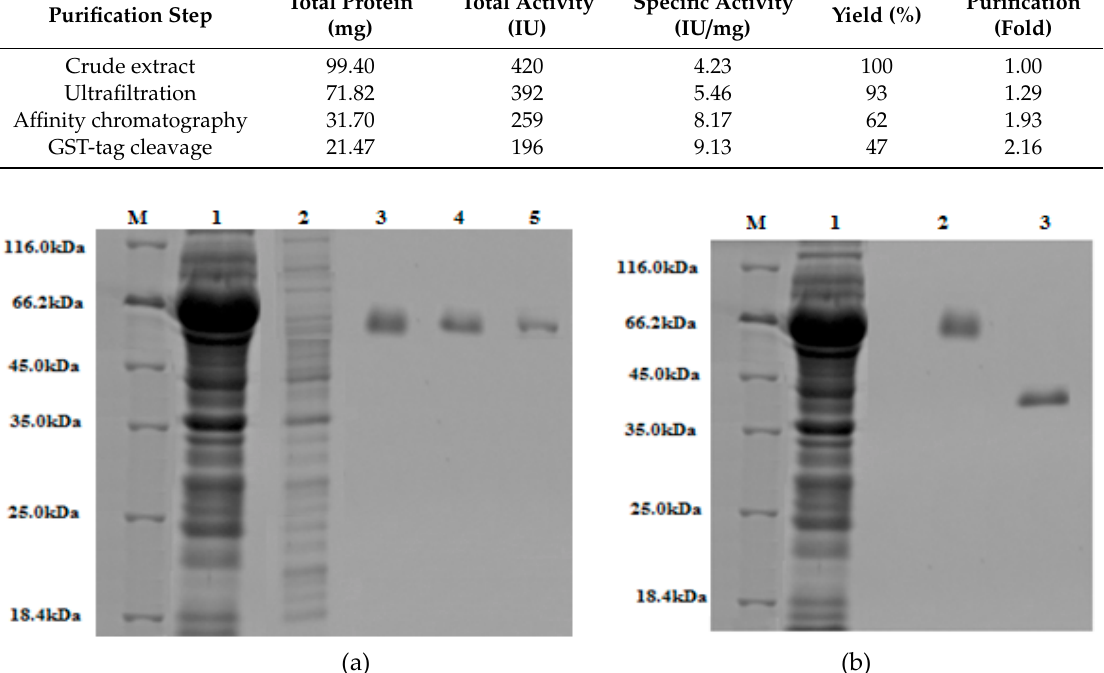
Table 10. S. griseus recombinant β -glucosidase purification table.